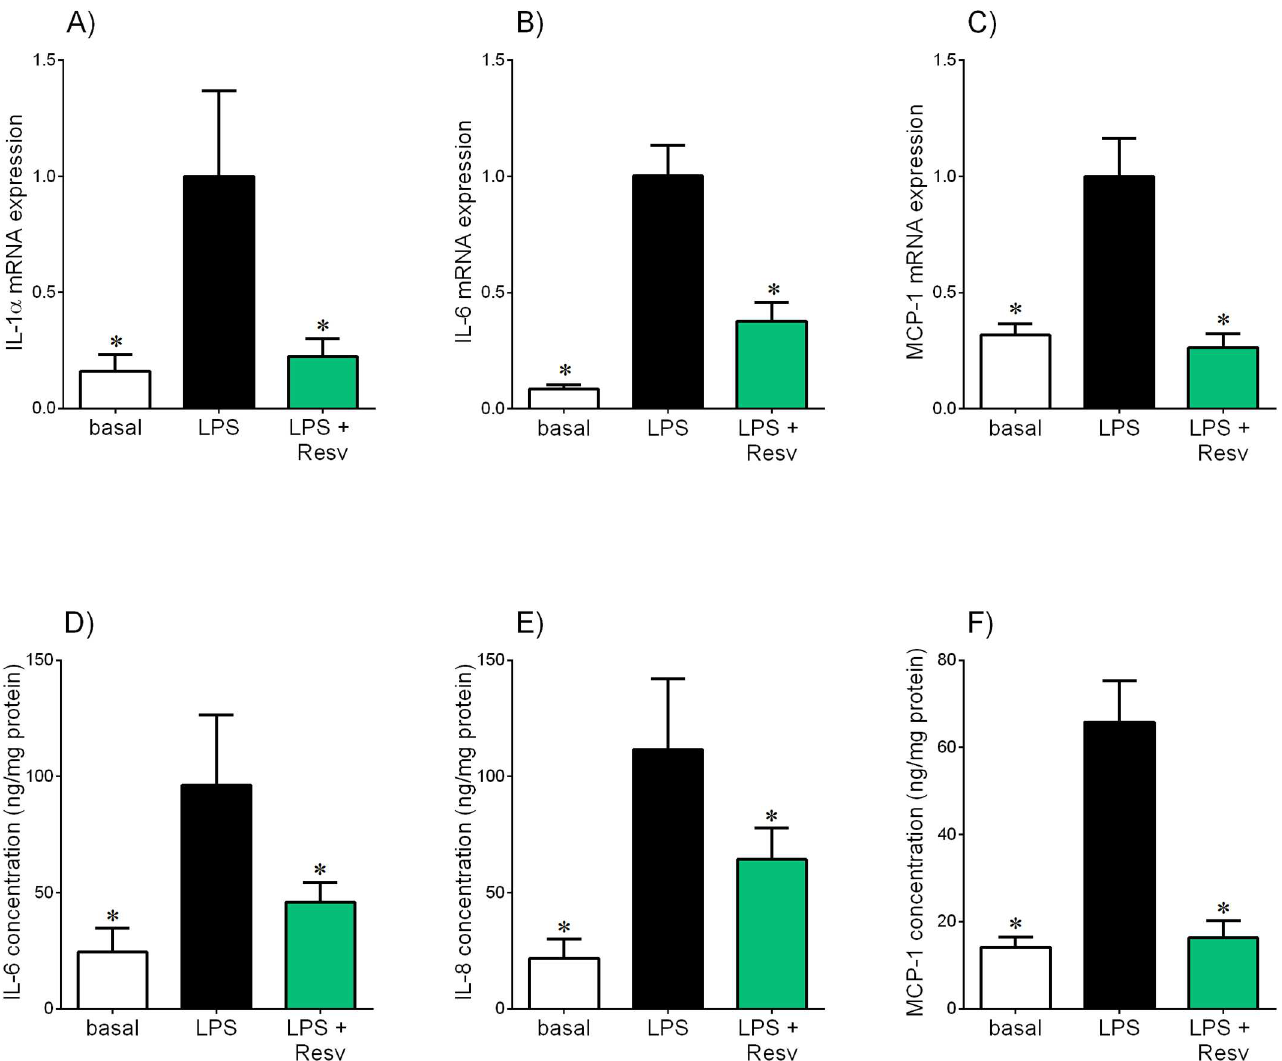
Fig 6. Effect of resveratrol on LPS-induced pro-inflammatory cytokines and chemokines in in omental adipose tissue. Human omental adiposetissue was incubatedwith 10 μ g/ml LPS in the absenceor presenceof 200 μ M resveratrol (resv) for 20 h (n = 6 patients). (A-C) IL-1 α , IL-6 and MCP-1 mRNA expressionwas analysedby qRT-PCR and the fold changewas calculatedrelative to LPS. (D-F) The incubationmedium was assayed for concentration of IL-6, IL-8 and MCP-1 release by ELISA. All data are displayedas mean ± SEM. * P < 0.05vs.